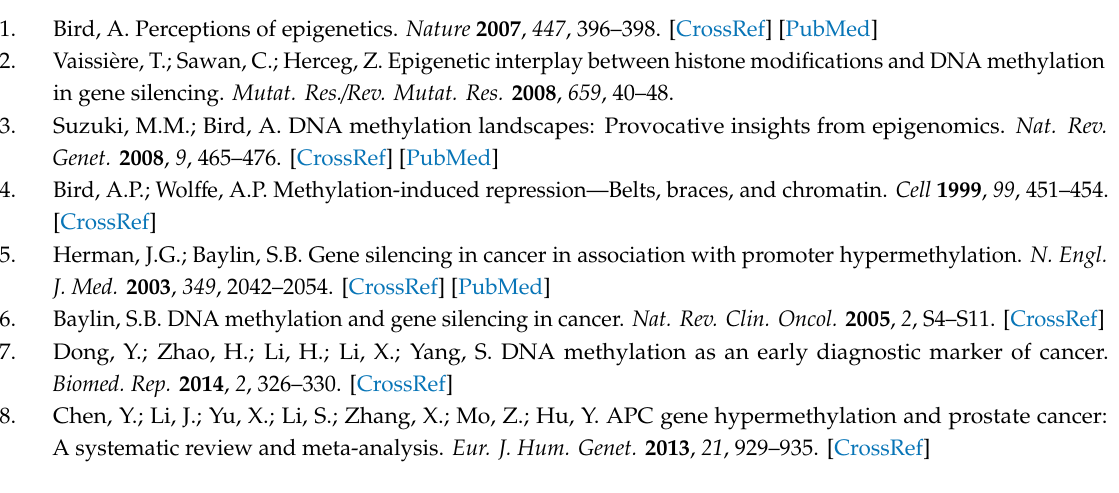
Figure S1: The cost and accuracy change in training progress, Figure S2: ROC of logistic regression for the three data sets, Figure S3: ROC of the randomly partition three data set, Figure S4: The detailed impact of each marker to the model output in four samples, Figure S5: Plot of accuracy with random sampling, Table S1: The overview of Training data set, Validation data set, and Test data set 1, Table S2: The sample details of 4840 cancer samples and 1742 matched normal samples (All were divided into Training data set, Validation data set and Test data set 1 as Table S1 shows), Table S3: The sample details of 727 cancer samples and 836 normal samples (All were added into Training data set), Table S4: The sample details of 3041 cancer samples and 268 matched normal samples (All were added into Test data set 2), Table S5: The sample details of 1532 cancer samples and 540 virtual normal samples (All were added into Test data set 3), Table S6: The sample details of cell-free DNA samples, Table S7: The range of hyper-parameters during random searching, Table S8: The prediction accuracy contrast between Deep learning and Logistic